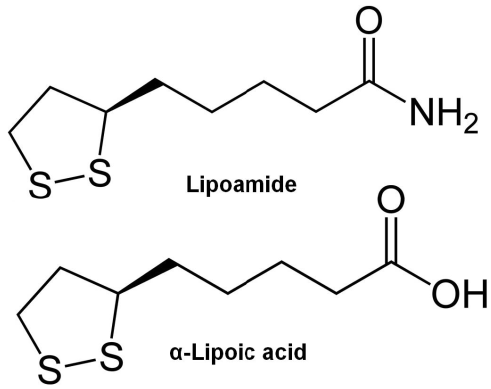
Figure 1. Structural formulas of antioxidants.